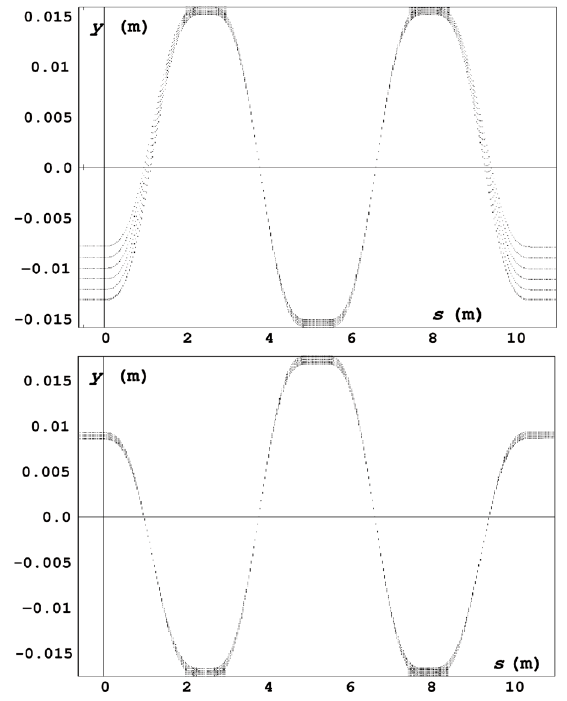
FIG. 34. Vertical closed orbits along 9 o ’ clock (top) and 3 o ’ clock (bottom) snakes, sampled over the helix current scan from vertical to radial